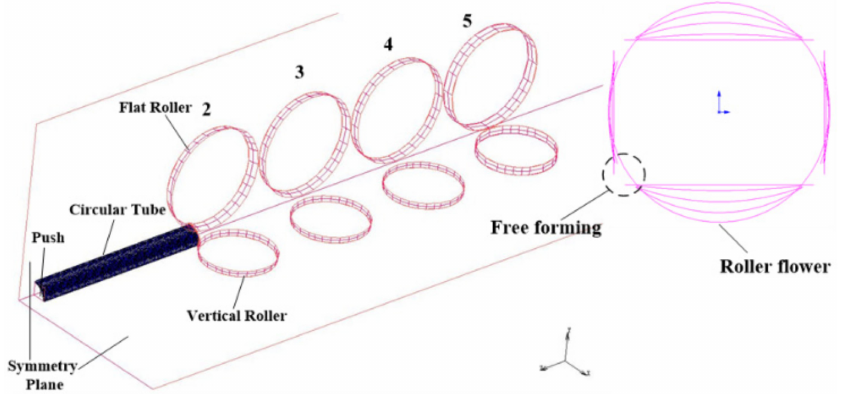
Figure 5. Simulation model of roll